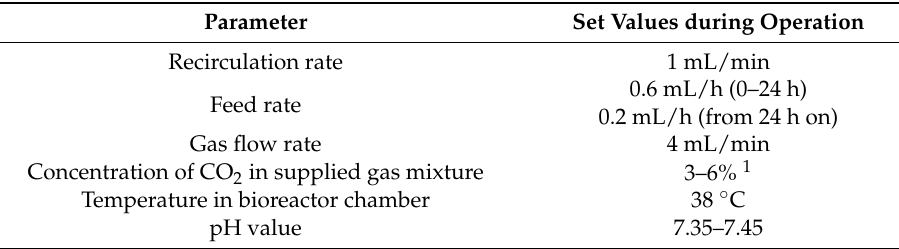
Table 1. Bioreactor perfusion parameters and operation conditions.